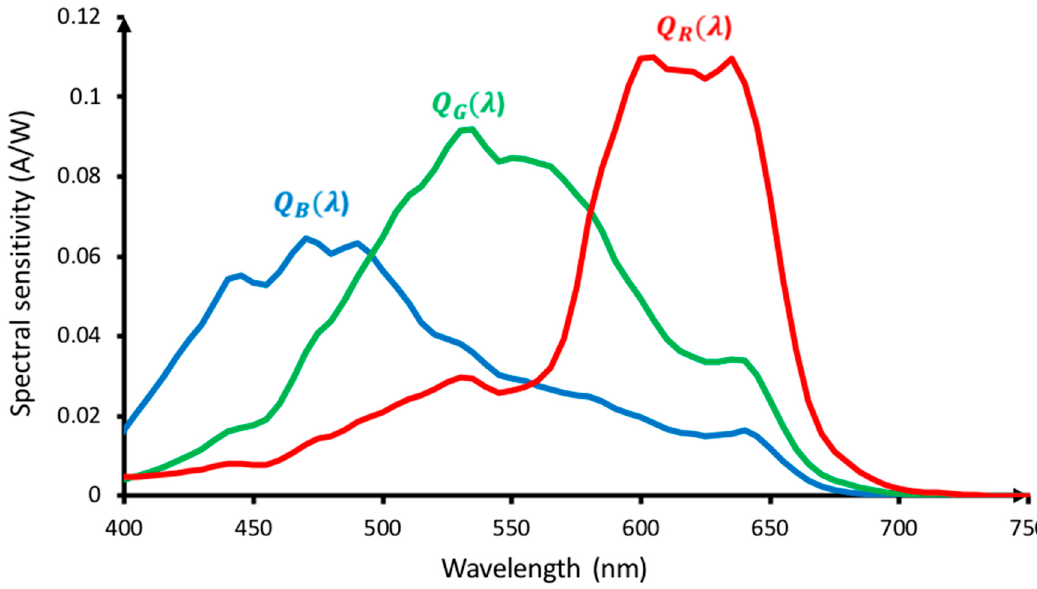
Figure 6. Relationship between spectral sensitivities and wavelength.